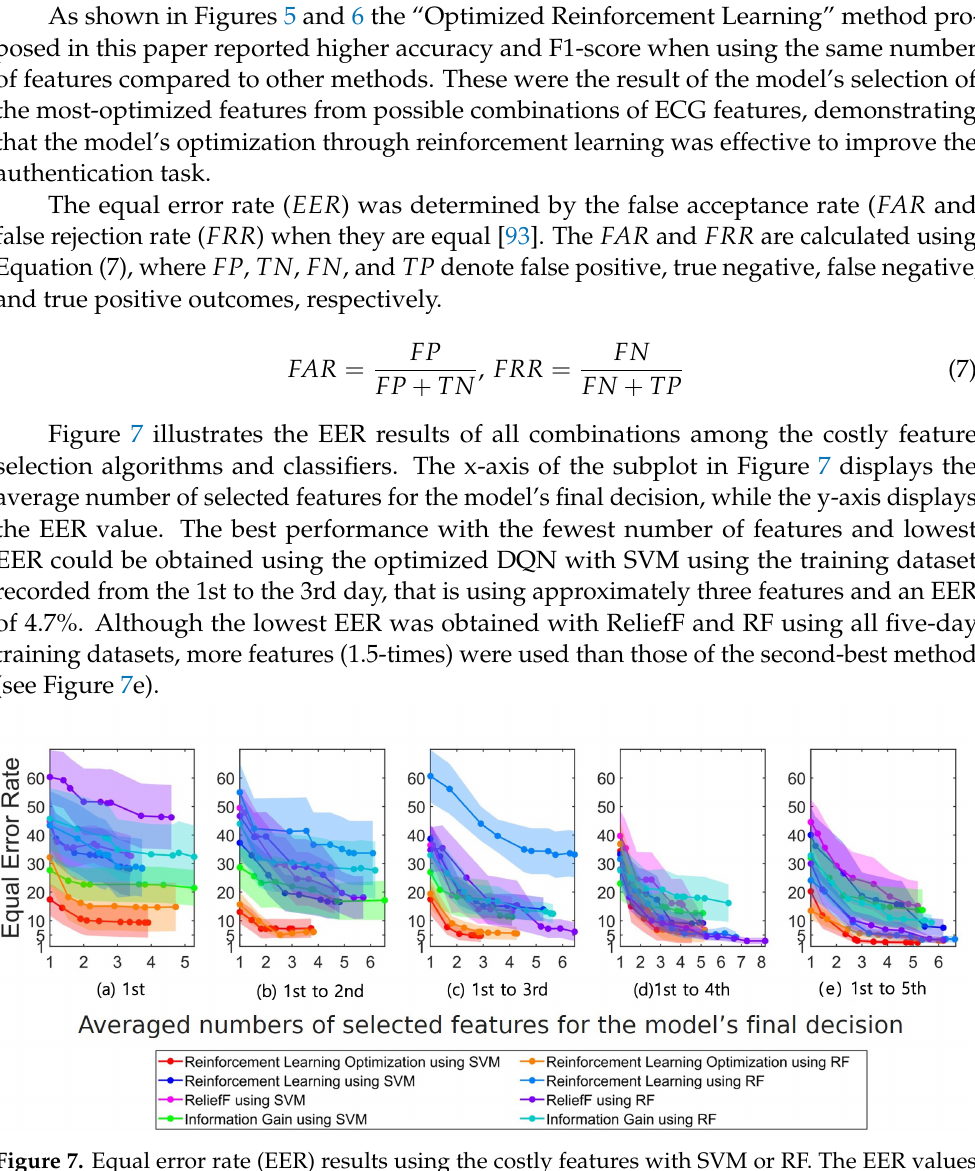
Figure 7. Equal error rate (EER) results using the costly features with SVM or RF. The EER values across all subjects are illustrated with their variances in shades (corresponding to the training days). Each training dataset includes the ECG signals recorded on the ( a ) 1st day, ( b ) 1st–2nd days, ( c ) 1st–3rd days, ( d ) 1st–4th days, and ( e ) 1st–5th